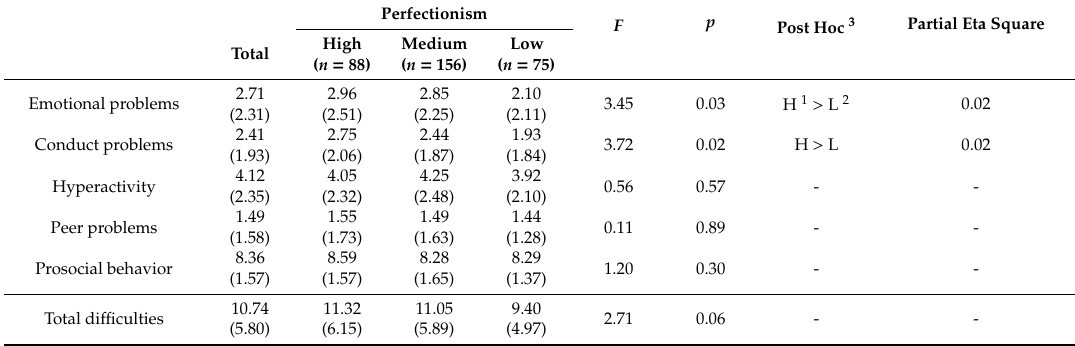
Table 4. Mean (Standard Deviation) for SDQ-C subscales among the three groups: high, medium, and low